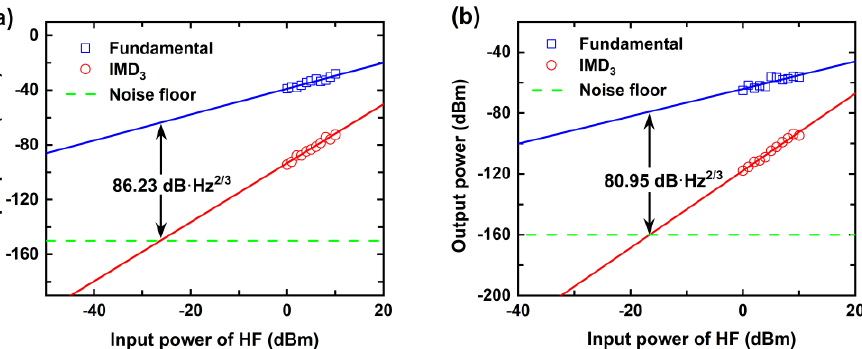
Figure 9. Spurious-free dynamic range (SFDR), ( a ) for upconversion and ( b ) for downconversion.